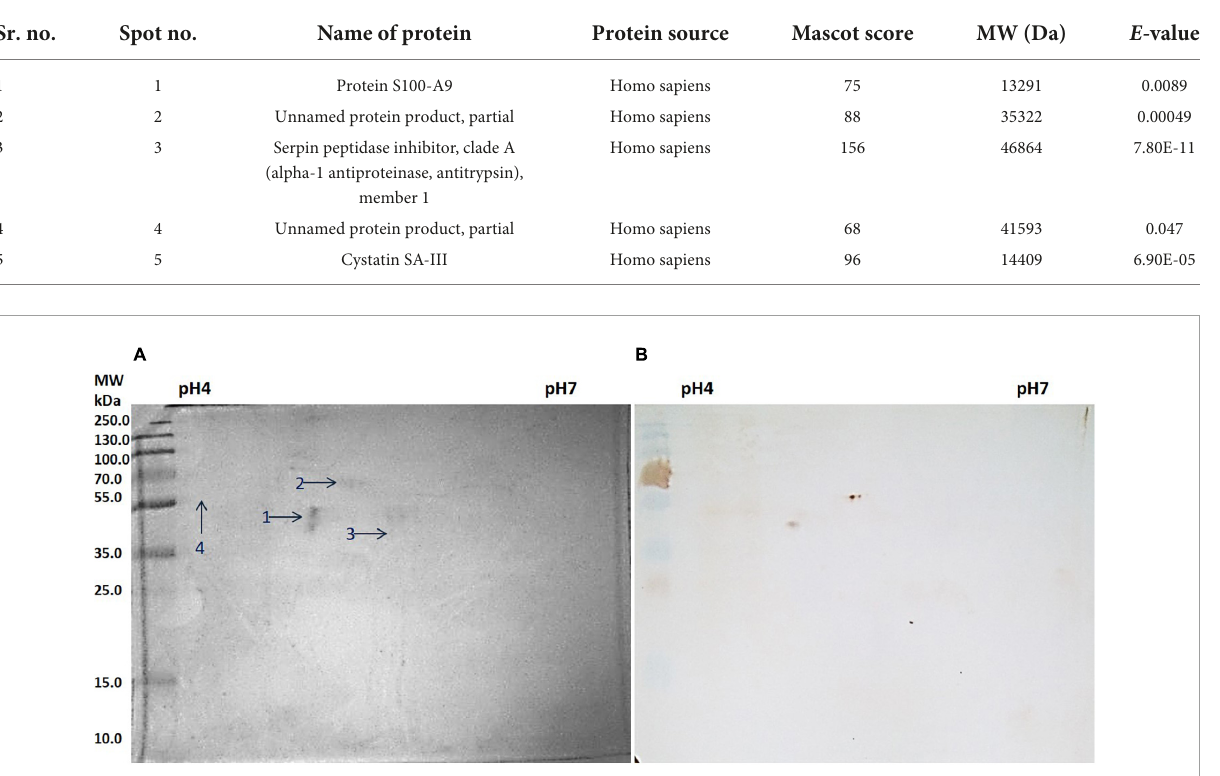
TABLE 2 The protein spots identified by MS/MS. Sr. no.